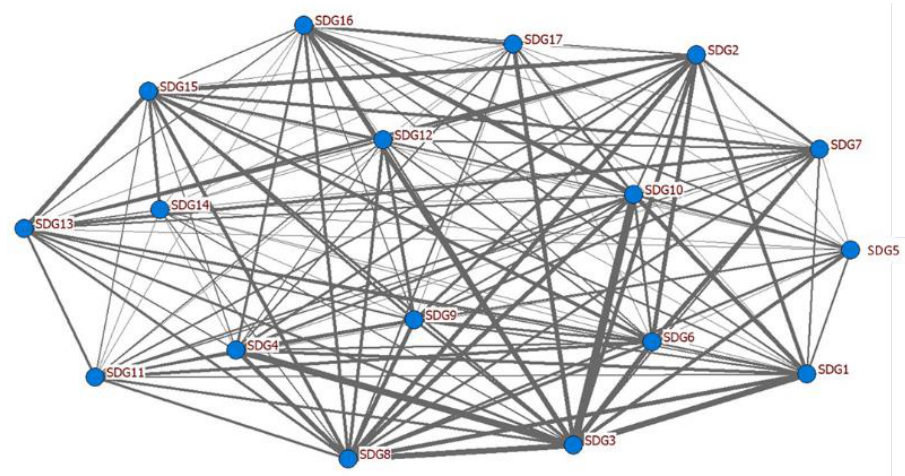
Figure 5. The elaborate network graph of 17 SDGs (generated using UCINET). In this study, the “degree centrality” of each SDG in the network means the ratio of average tied frequencies incident upon it (the numerator in Equation (2)) to the most considerable tied frequency among all possible SDG pairs in the whole matrix (the denominator in Equation (2)). A higher degree centrality means the SDG had more connections / linkages with other SDGs. The top ten SDGs were shown in Table 3. Because network analysis often is applied for social science, it helps to clarify the power structure of actors. Here, each SDG as a conceptual actor is manipulated by the academic or communicative community. Thus, SDG 3 and SDG 10 were the most important goals within the network and possessed the support of both the academia and the media industries. Table 3. The top ten SDGs with highest degree centralities in the network with 136 SDG pairs.